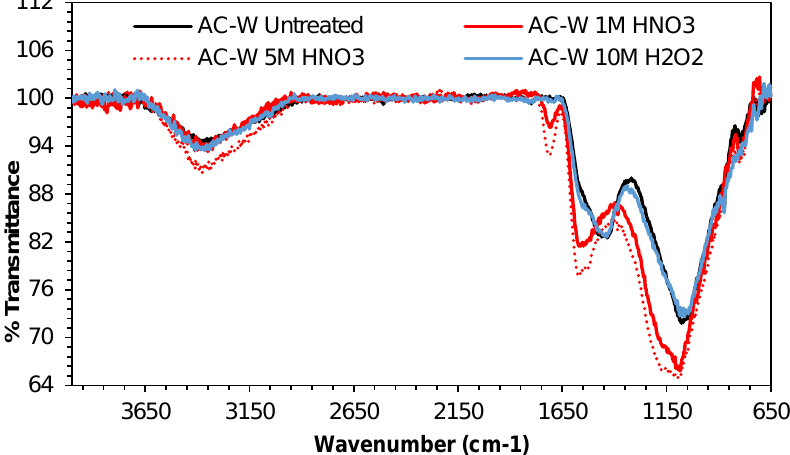
Figure 6. FTIR Spectra for AC-W (wood-based) untreated, nitric treated, and peroxide treated.